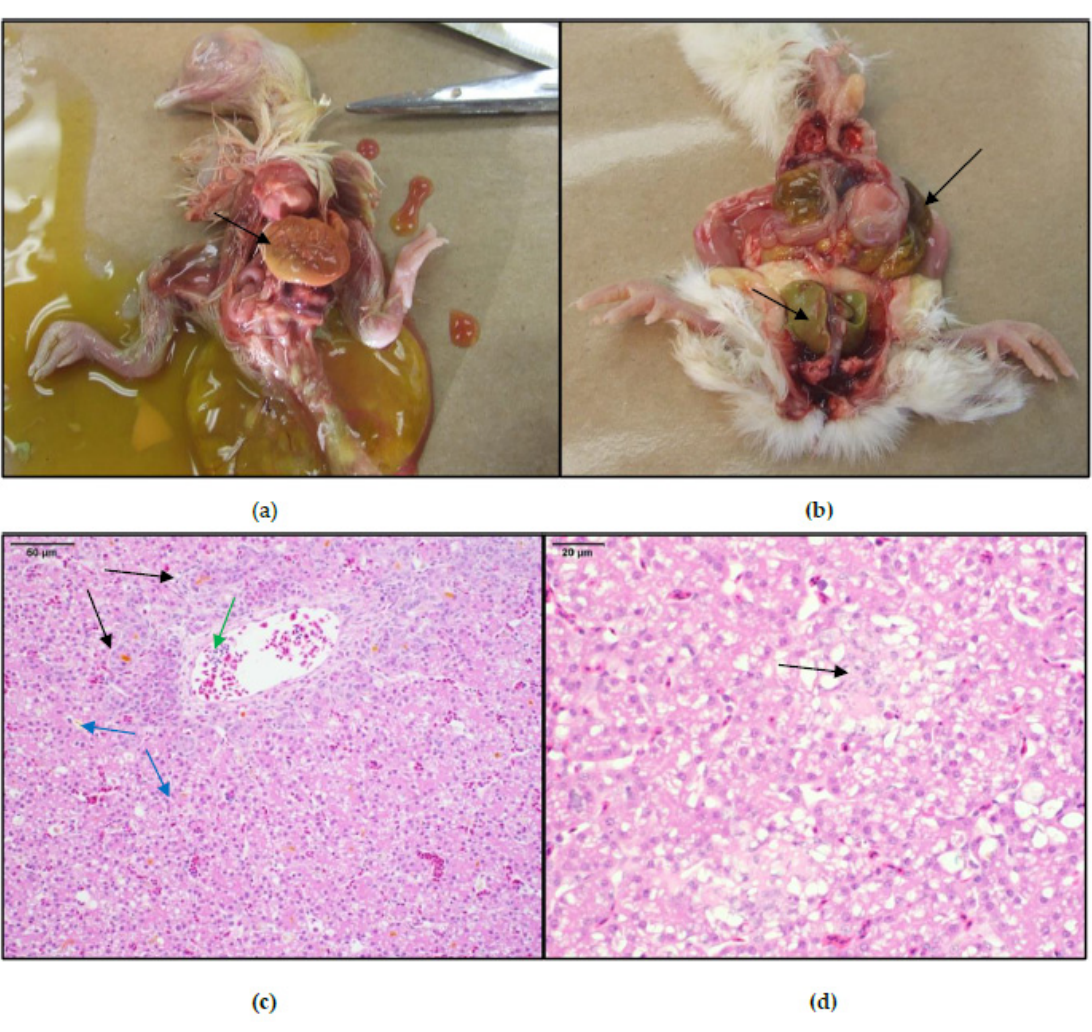
Figure 2. Post-mortem examination on dead-in-shell embryos and culls of case 15-1262a, and histopathology of cases 14-1235a; and 15-1262a, respectively. Dead-in-shell embryo with enlarged firm green livers in ( a ). Day-old culled chick with white plumage showing enlarged firm green liver and unabsorbed yolk-sac contents with visible green discoloration in ( b ). CAstV microphotographs of histopathological liver lesions on white chick syndrome (WCS) clinical cases. Case 14-1235a shows in 20× ( c ), proliferating bile ducts in black arrows, bile in canalicular lumens in blue arrows, and heterophils and macrophages in the portal vain in the green arrow. Case 15-1262a ( d ) shows in 40× one small foci of acute hepatic necrosis (black